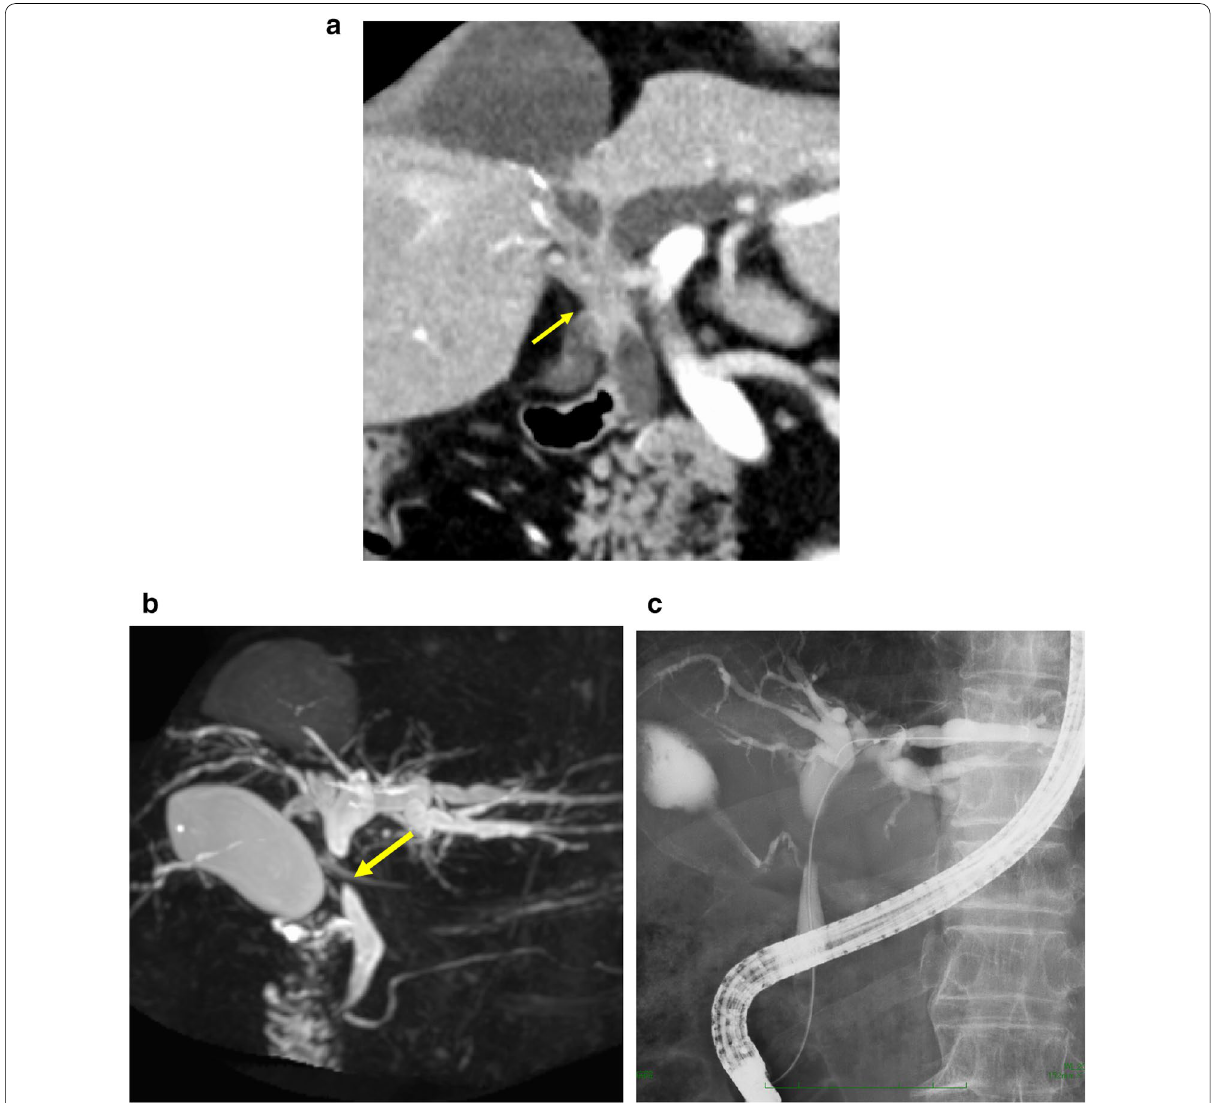
Fig. 1 a Enhanced CT revealed an enhanced wall thickness in the hilar bile duct. b , c Magnetic resonance cholangiography, endoscopic retrograde cholangiography and intraductal ultrasound showed that the tumor had grown into the bile duct